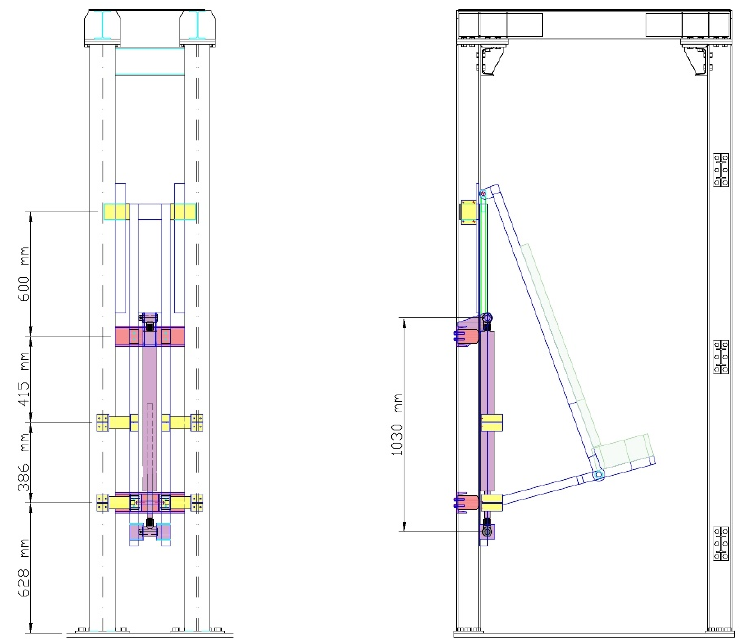
Figure 15. Details of the shock-absorber system (frontal and lateral views).